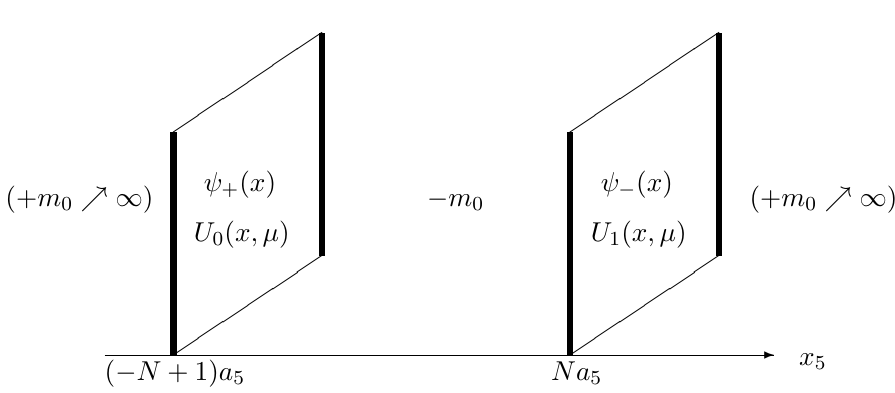
Figure 1 . Domain wall fermion in the simpler vector-like